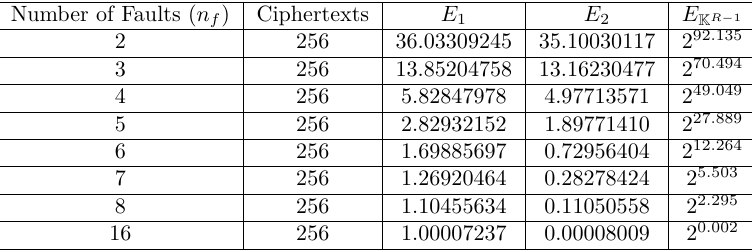
Table 3: The remaining key search space of AES-128.